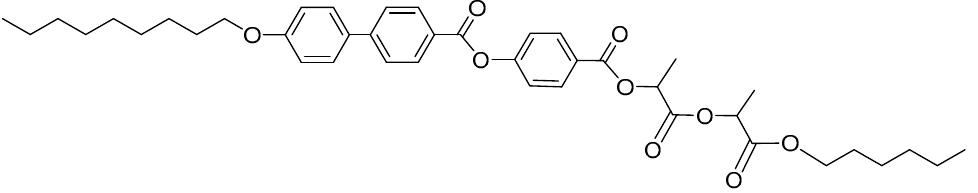
Figure 2. Chemical structure of ferroelectric smectic compound, namely (4-(((1-((1-(hexyloxy)-1- oxopropan-2-yl)oxy)-1-oxopropan-2-yl)oxy)carbonyl)phenyl